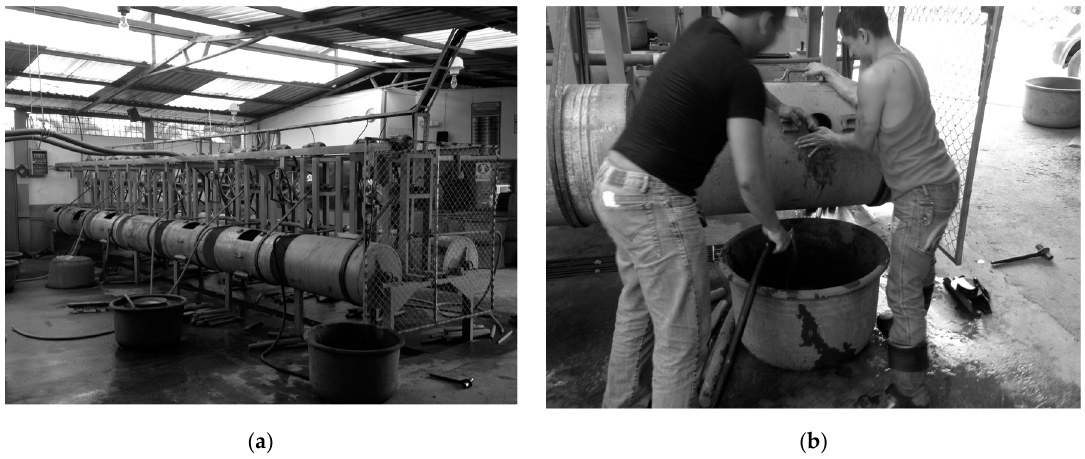
Figure 1. ( a ) “Chanchas” in a plant near Villa river, ( b ) Chancha discharge process.